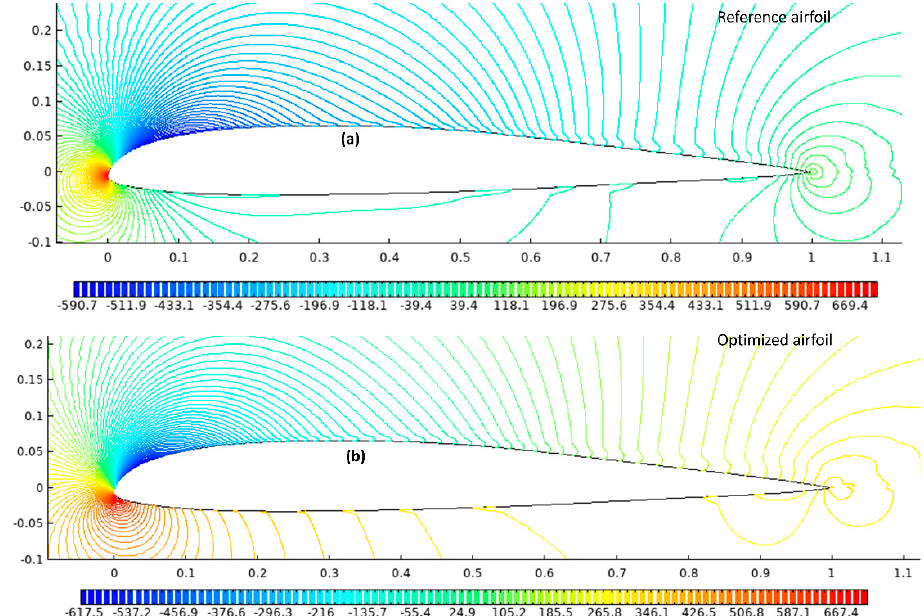
Figure 12. Comparison of pressure variations for the UAS-S45 optimized airfoil for drag minimization. ( a ) Reference airfoil, ( b ) Optimized airfoil.